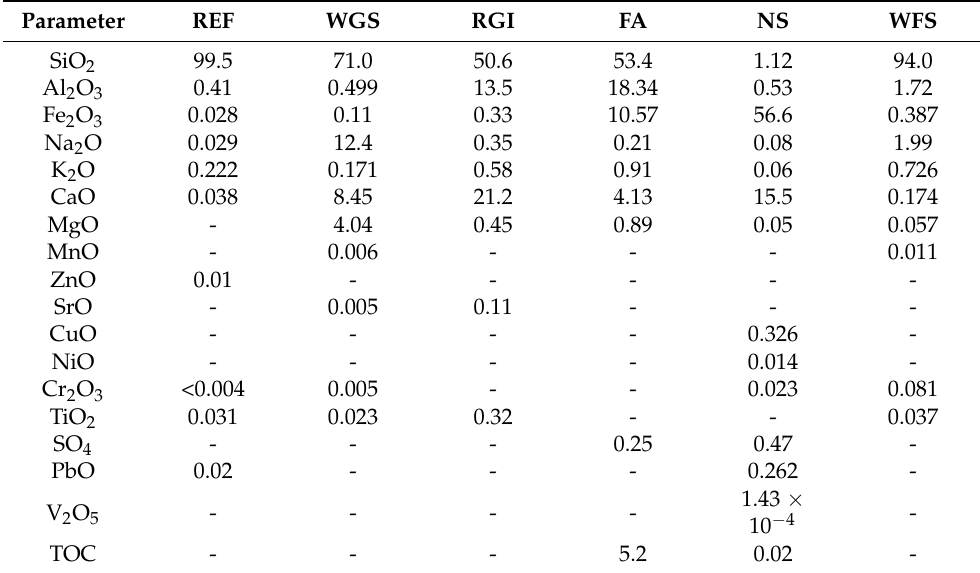
Table 3. Chemical composition of the fillers (% dry matter).